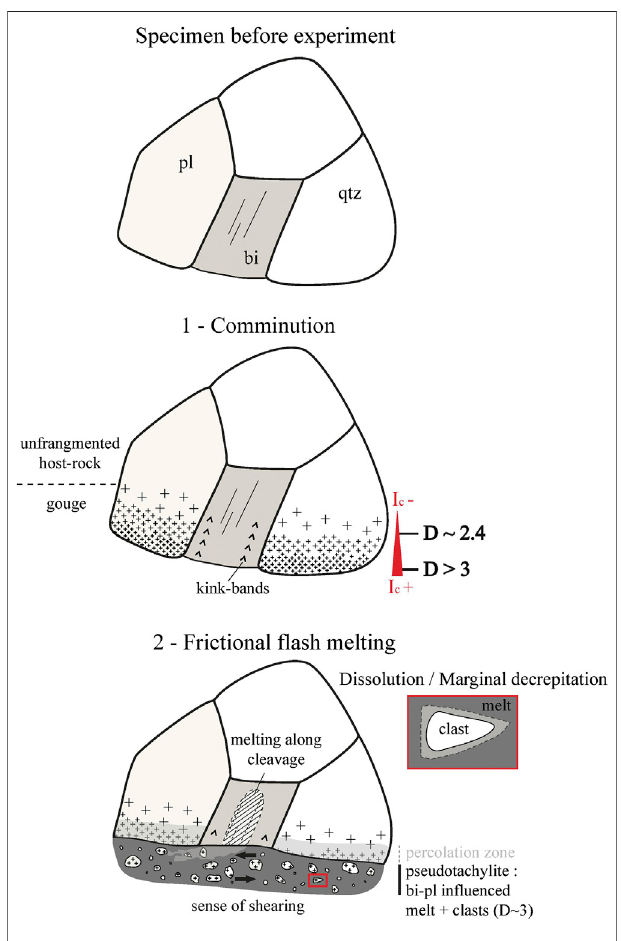
FIGURE 8 | Unscaled schematic representation of the processes occurring during the generation of experimental pseudotachylite and relative chronology (fragmentation, frictional fl ash melting and marginal decrepitation). Therelativechronology isnotassociatedwithtime astheprocessisvery fast (less than 5 s). I C : Intensity of comminution. D: Fractal dimension. Cross marks represent the limit of fragmention of the material, with small marks symbolising high fragmentation. The light gray borders around the clast in the zoomed red box represents the part of the clast that is dissolved by the melt.